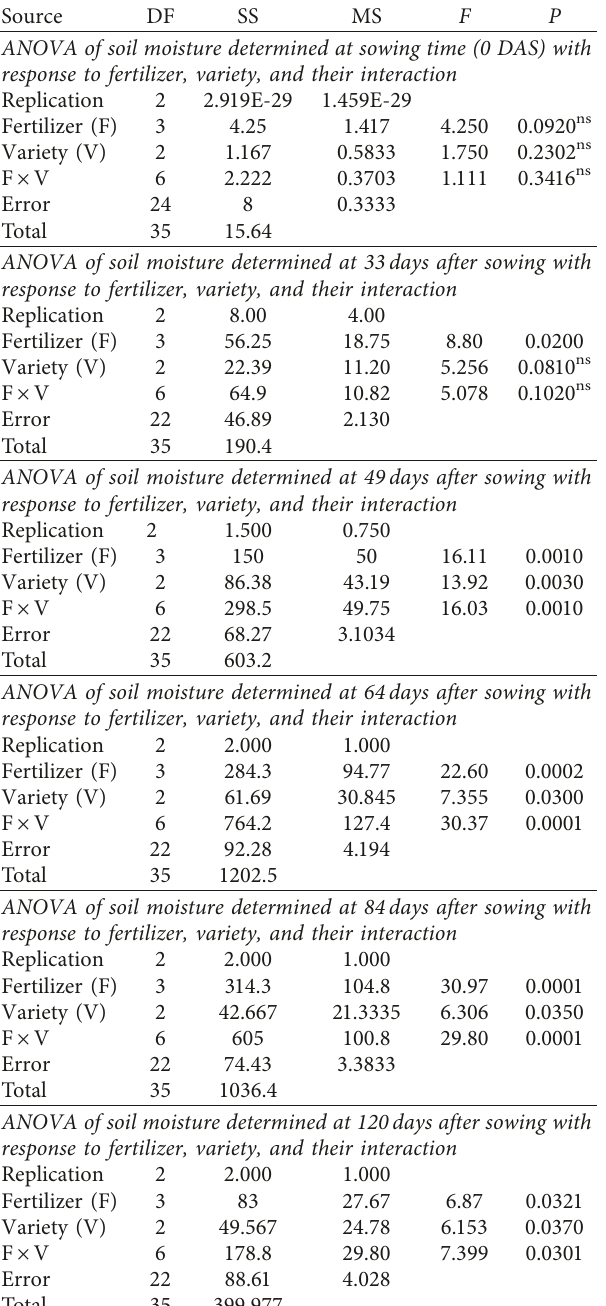
Table 2: Analysis of variance (ANOVA) for fertilizer rates, tef varieties, and their interaction effects on soil moisture determined at the different crop growth stages in northern Ethiopia (2012 cropping